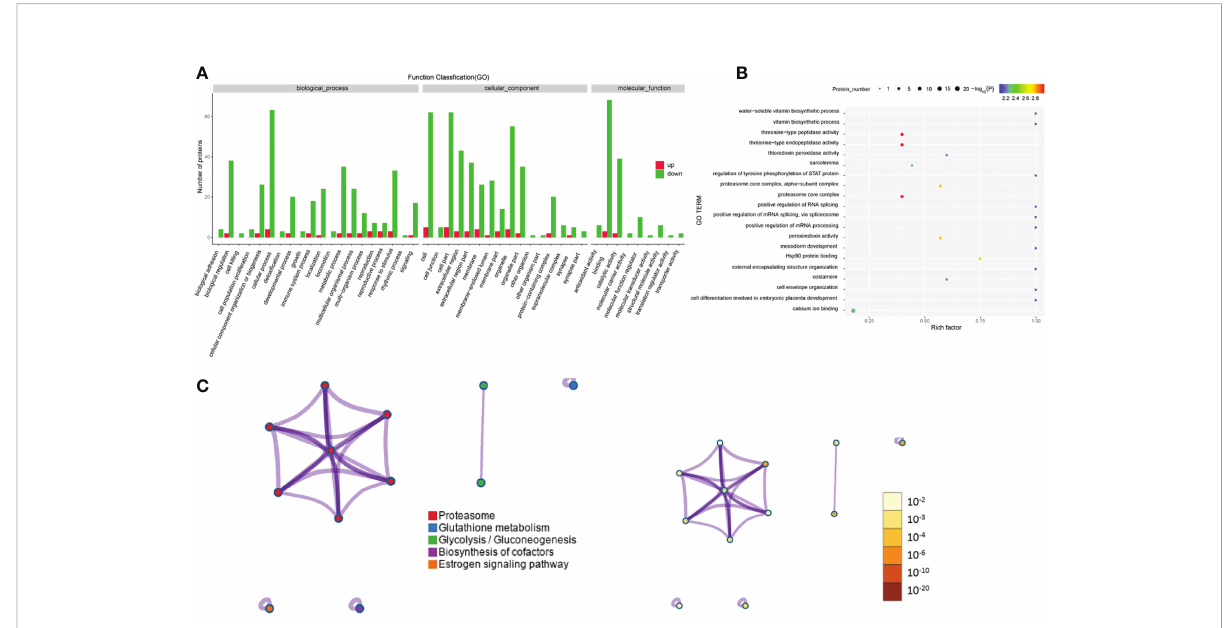
FIGURE 4 Gene Ontology and KEGG analyses of differentially expressed proteins from the GD group and the healthy control group. (A-C) GO annotation (A) , GO enrichment (B) , and KEGG enrichment (C) analysis of differentially expressed proteins in exosomes from the GD group and the healthy control